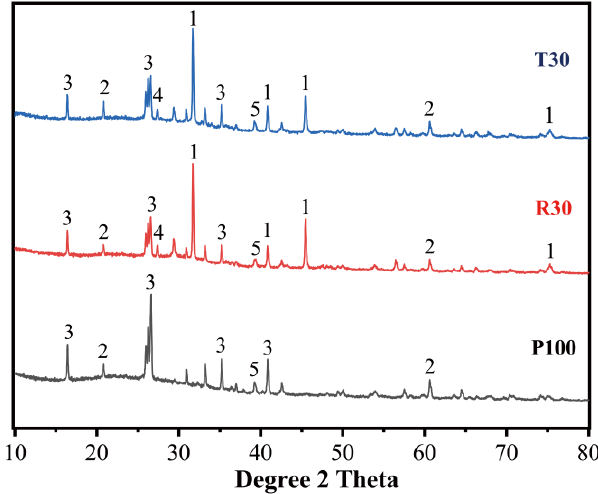
Figure 12. Effect of incorporating MSWIFA on XRD patterns of pastes (1-NaCl (PDF#88-2300), 2-SiO 2 (PDF#75-0443), 3-Mullite (PDF#84-1205), 4-C-S-H (PDF#14-0035), 5-Na 6 Al 4 Si 4 O 17 (PDF#39-0299).